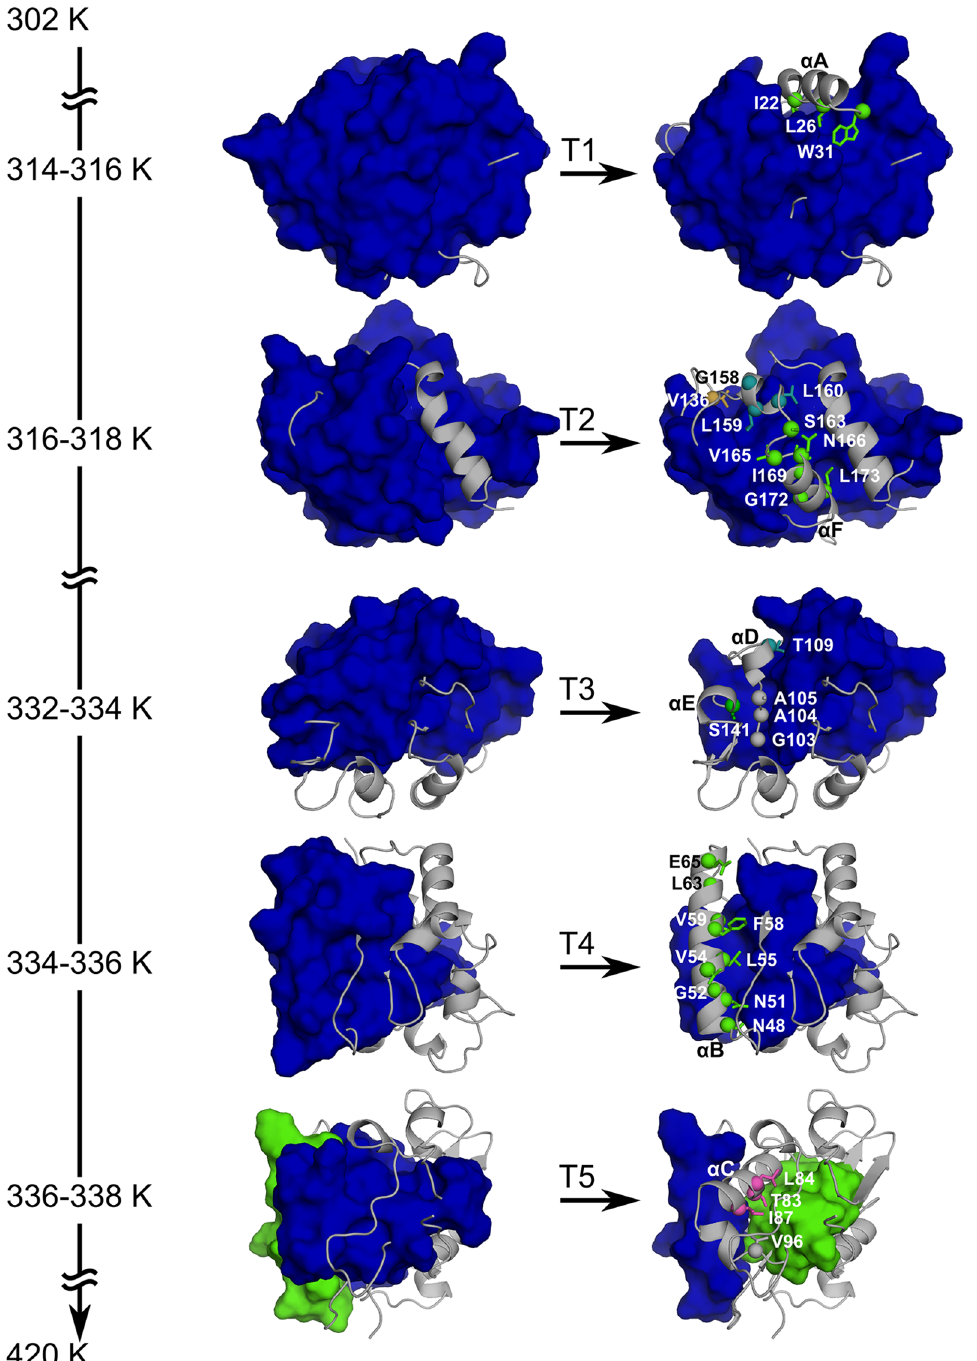
Fig 2. Thermal unfolding trajectory of WT Bs LipA showing transitions for which weak spot residues were identified. Uniformly colored bodies represent rigid clusters; for clarity, only the largest rigid cluster (blue) is shown for the first four transitions (T1 – T4), and the two largest rigid clusters (blue and green) are shown for the last transition (T5). C α atoms of the identified weak spot residues are shown as spheres, and side-chain atoms are shown in stick representation. Weak spot residues are colored according to the rigid cluster they are part of (rigid clusters are assigned blue, green, magenta, cyan, and orange colors in the descending order of their size in terms of the number of residues); a weak spot residue colored in gray indicates that it is part of a rigid cluster composed of less than three residues. Weak spot residues that are highly conserved in the multiple sequence alignment of the lipase family are not shown. Important helices that segregate from the largest rigid cluster at the respective transition are